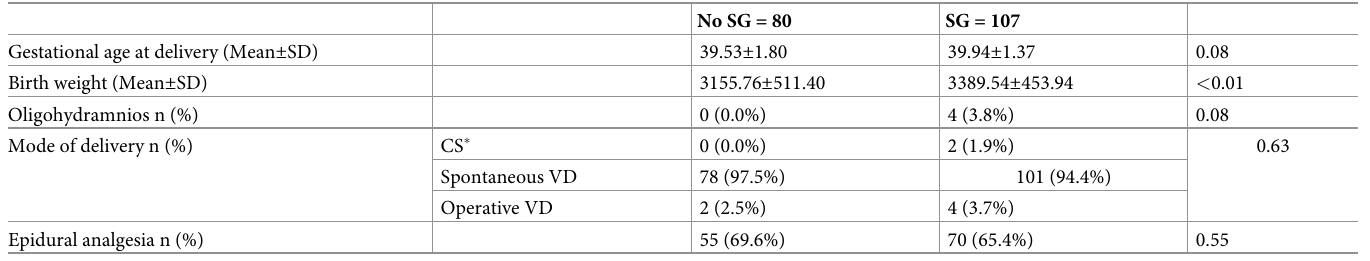
Table 2. Delivery characteristics of the study groups stratified by the presence of SG.